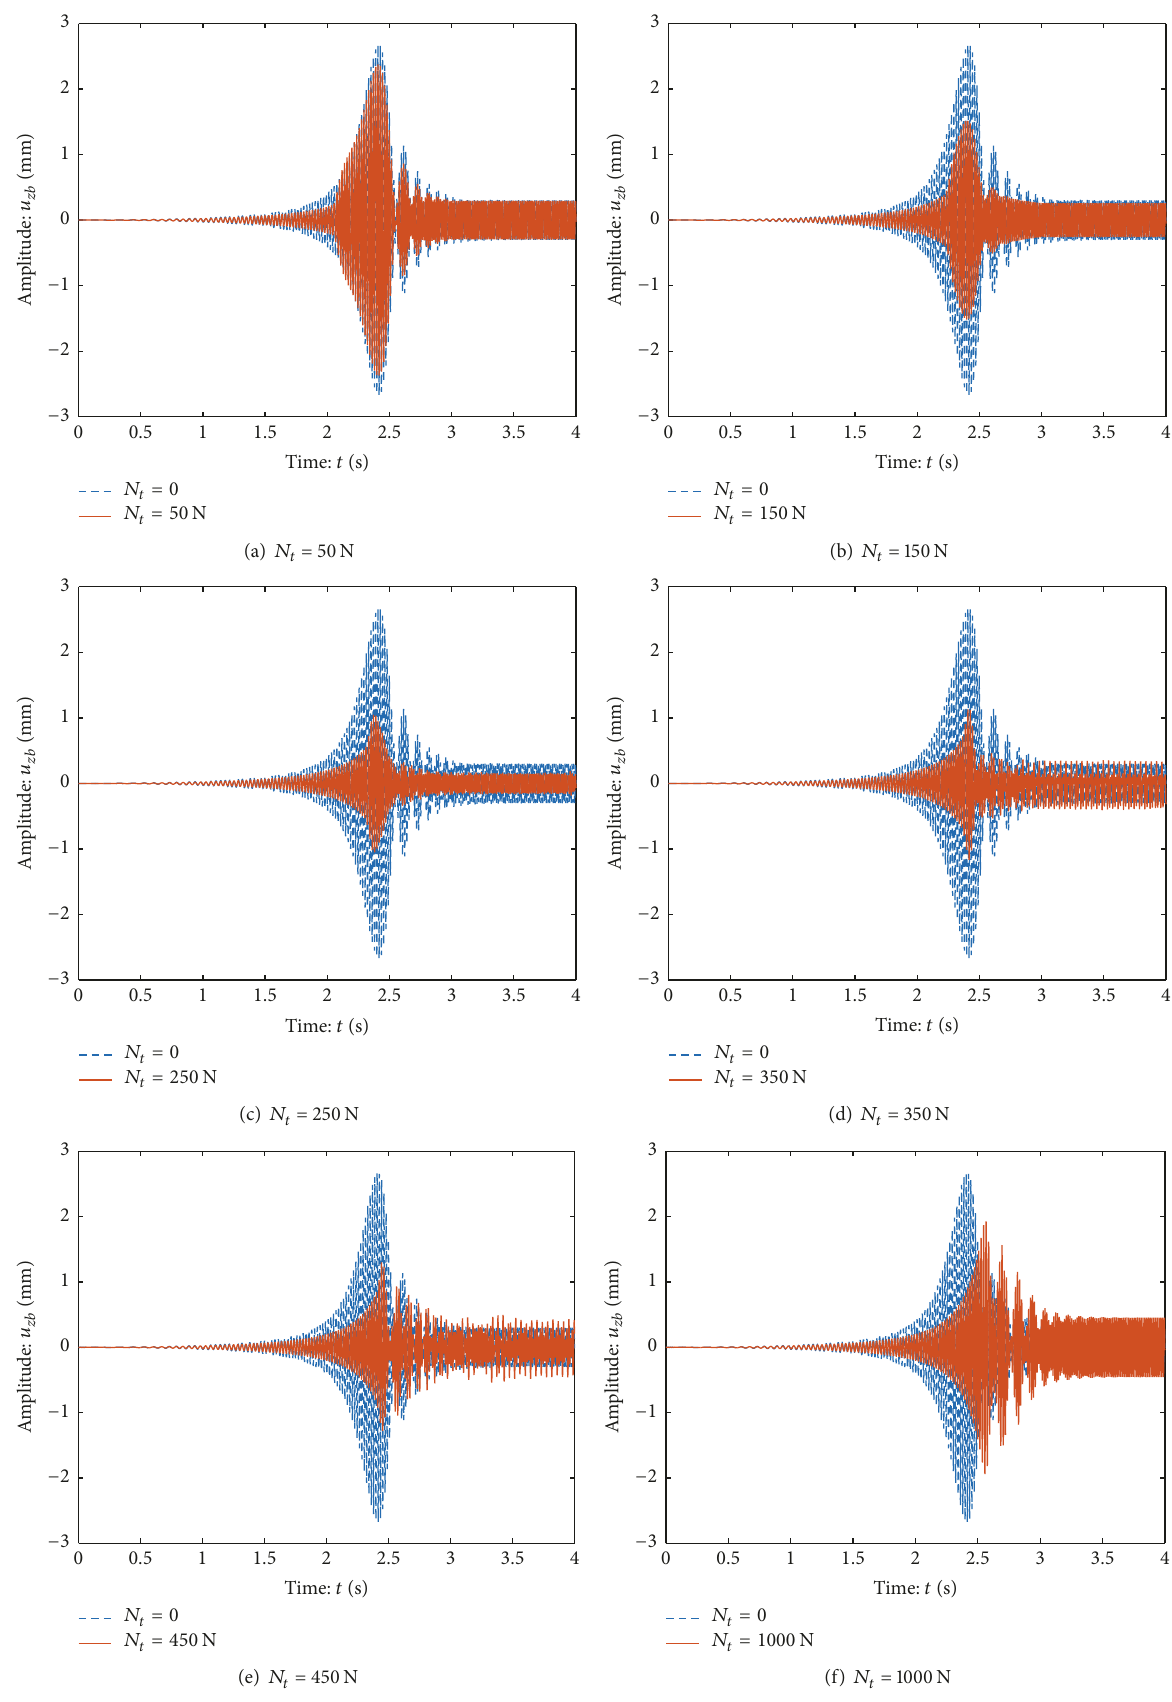
Figure 5: Bending vibration response of the tail shaft in the 𝑥 0 direction accelerating to exceed the critical